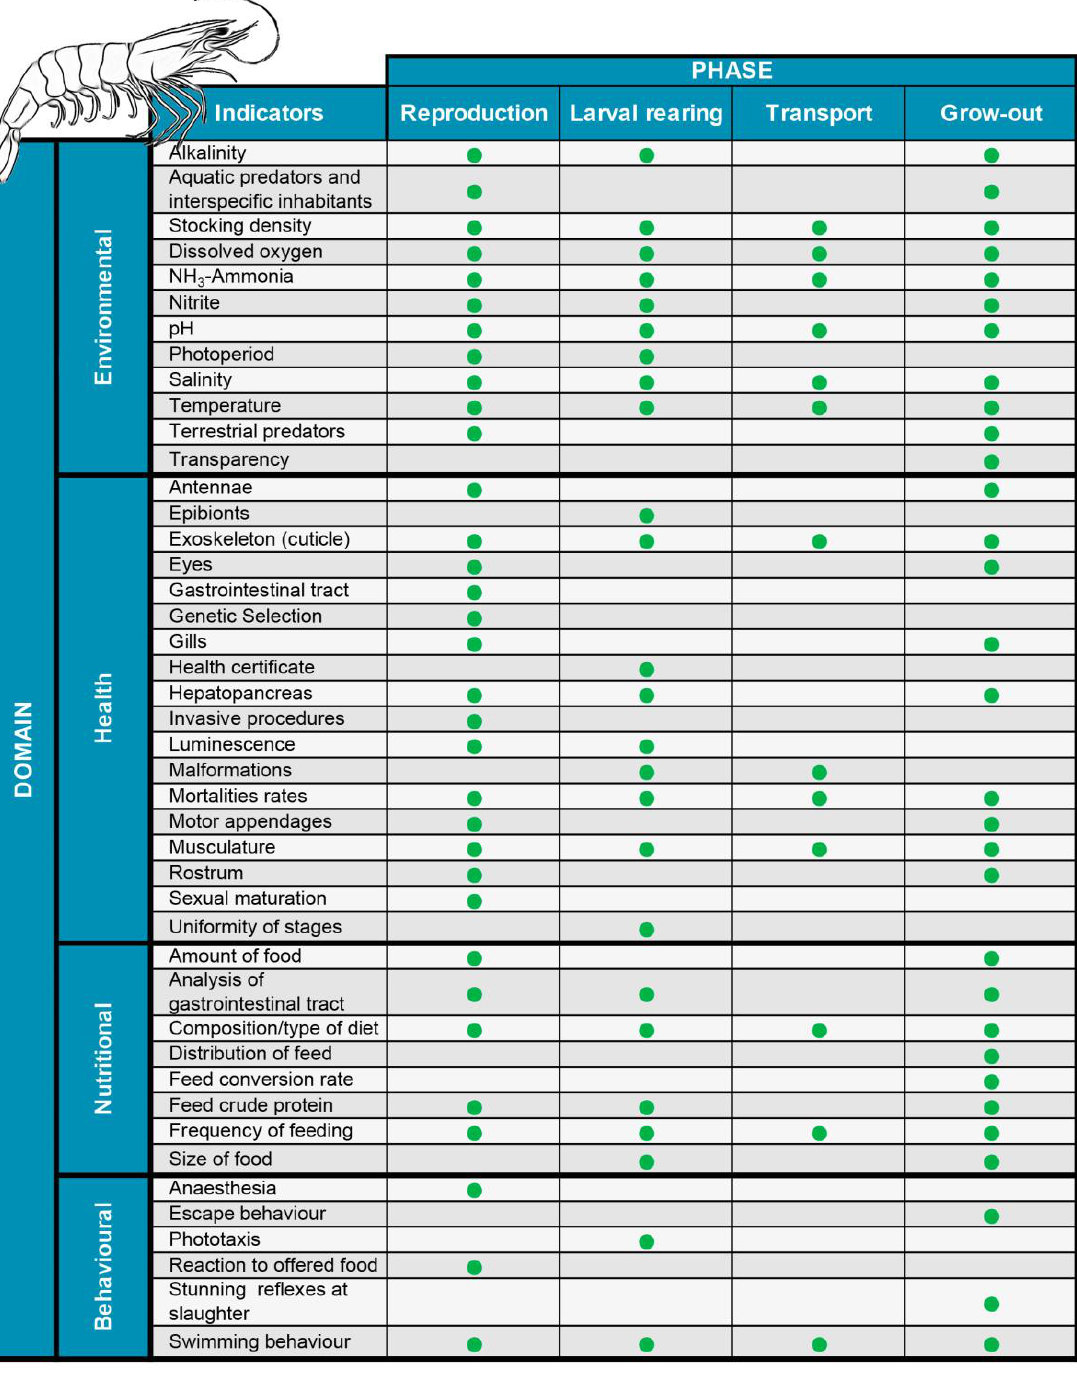
Figure 1. Domains and welfare indicators during the production process of white-leg shrimp, Pe- naeus vannamei